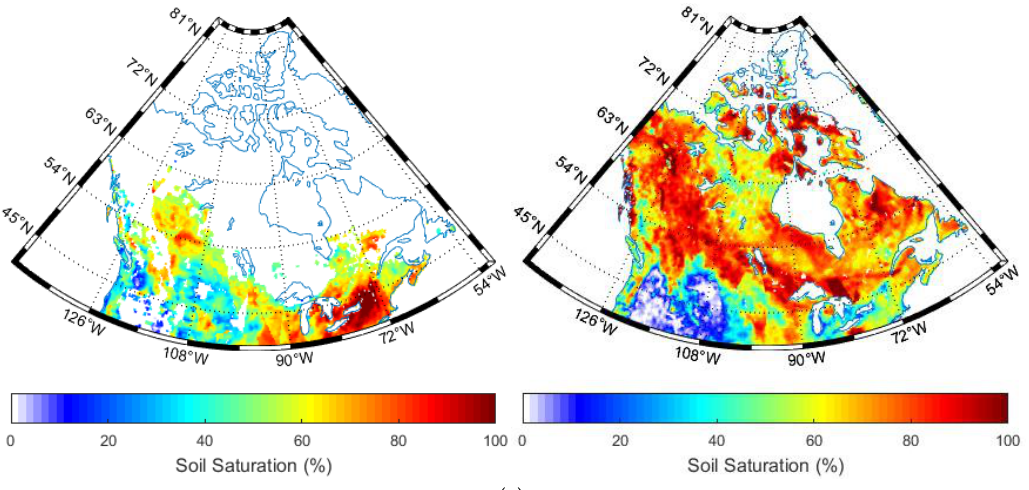
Figure 9. Temporal evolutions of ( a ) CCI retrieved and in-situ measured soil moisture ( b ) temperature in the REMEDHUS